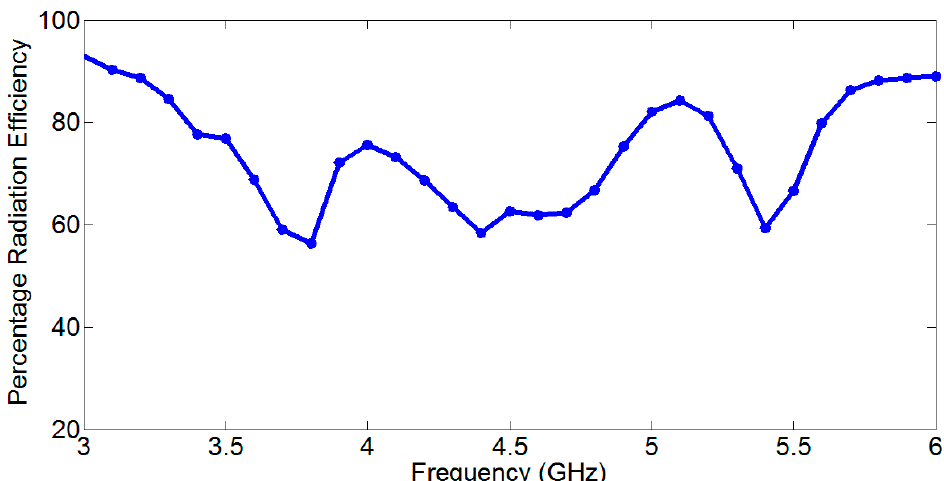
Figure 18. Percentage radiation efficiency of the proposed developed frequency scanning fan beam array antenna with an integrated bandpass filter.